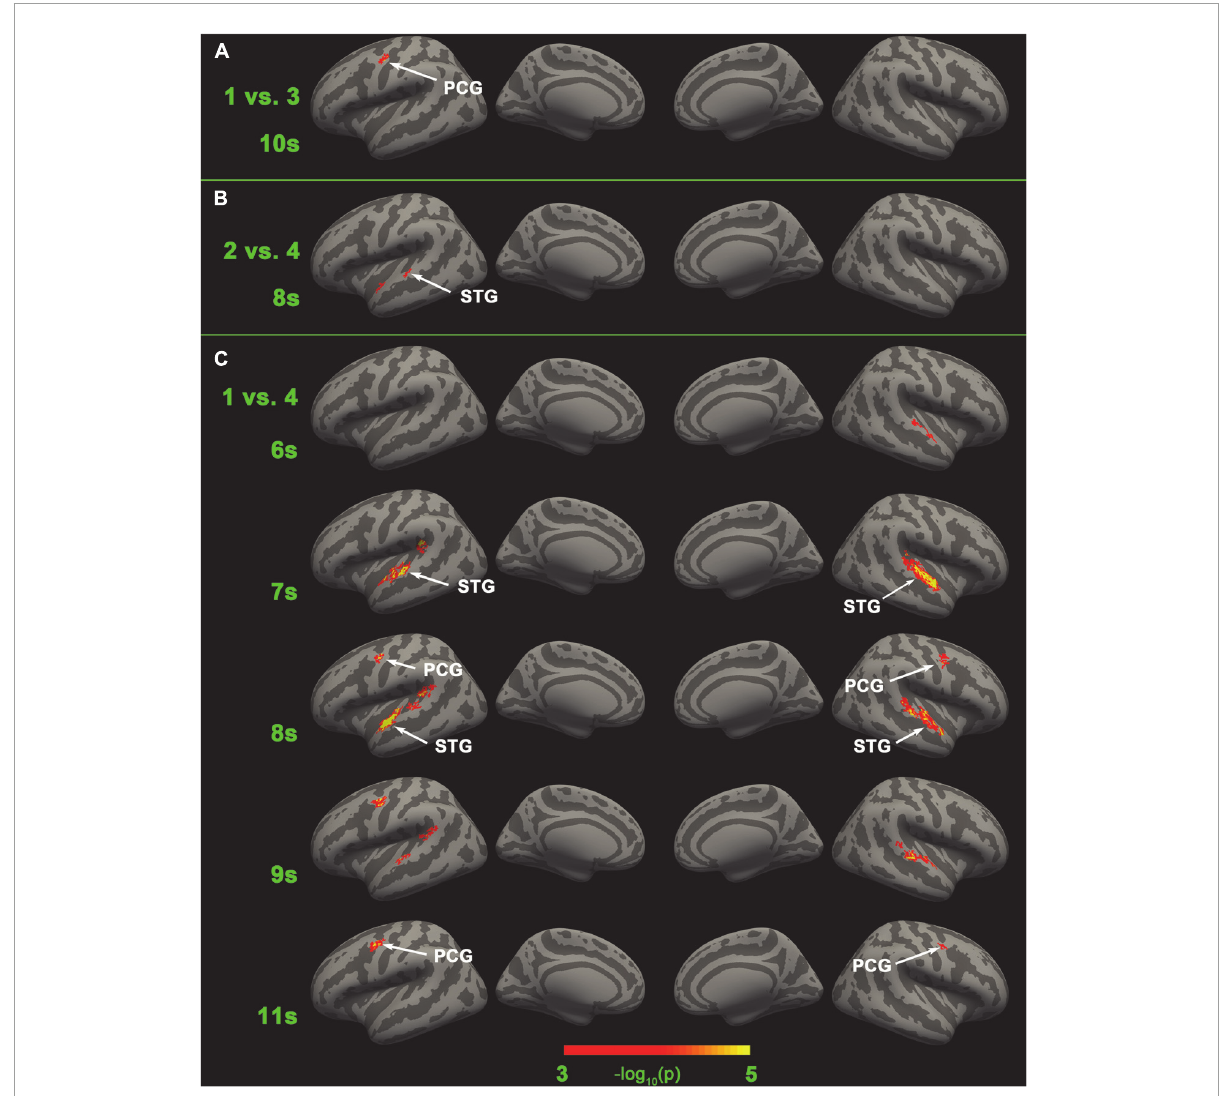
FIGURE6 Brain areas that have significant different neural coding for different tonal working memory loads. No brain area has significant different neural coding for adjacent tonal working memory loads. (A) The left PCG has significant different neural coding for load 1 vs. load 3 in the 10th second. (B) The left STG has significant different neural coding for load 2 vs. load 4 in the 8th second. (C) The left STG has significant different neural coding for load 1 vs. load 4 in the 7 ∼ 9 s. The right STG has significant different neural coding for load 1 vs. load 4 in the 6 ∼ 9 s. The bilateral PCG has significant different neural coding for load 1 vs. load 4 in the 8 ∼ 11